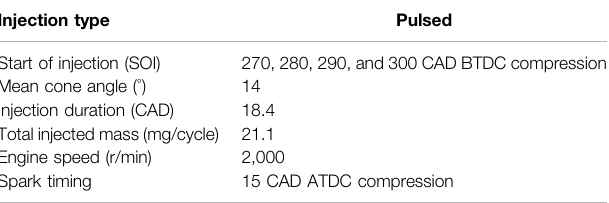
TABLE 2 | Simulated operating conditions at various injection timings Injection type Pulsed